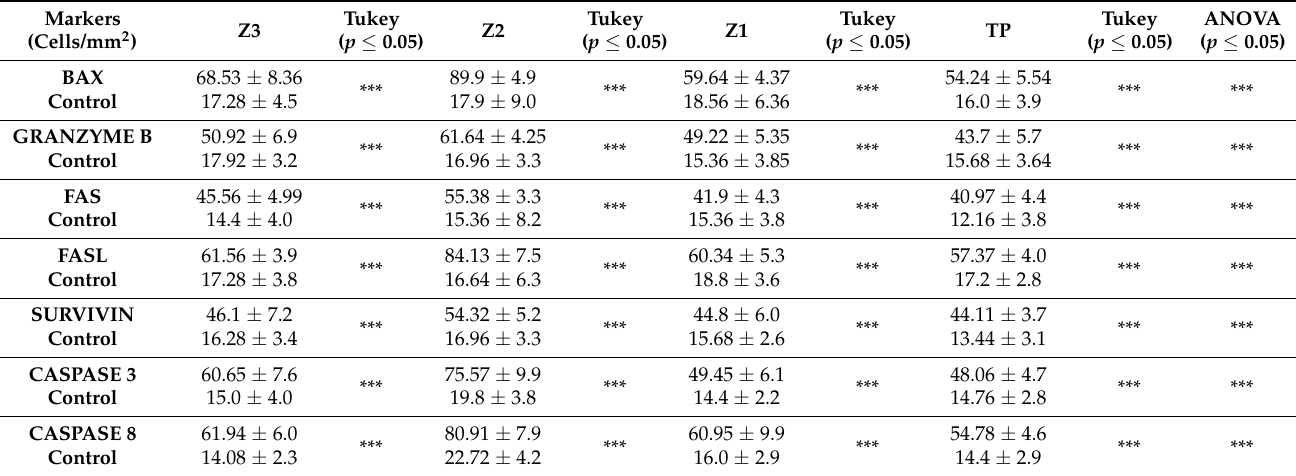
Table 2. Quantitative analysis of apoptotic markers in the hepatic parenchyma (Z3, Z2, Z1, and PT) in fatal YFV cases.